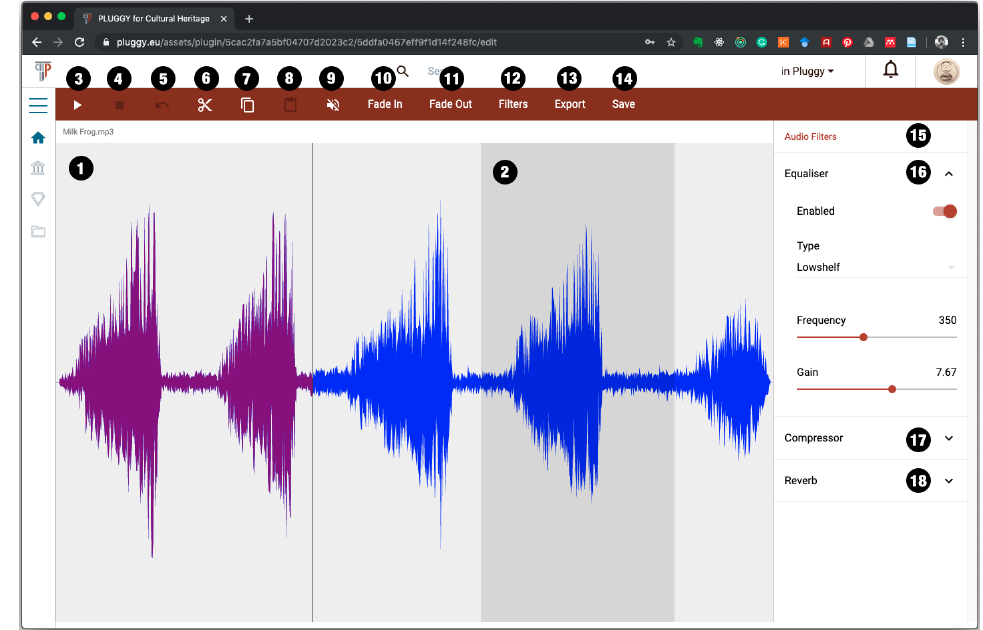
Figure A1. PlugSonic Sample user